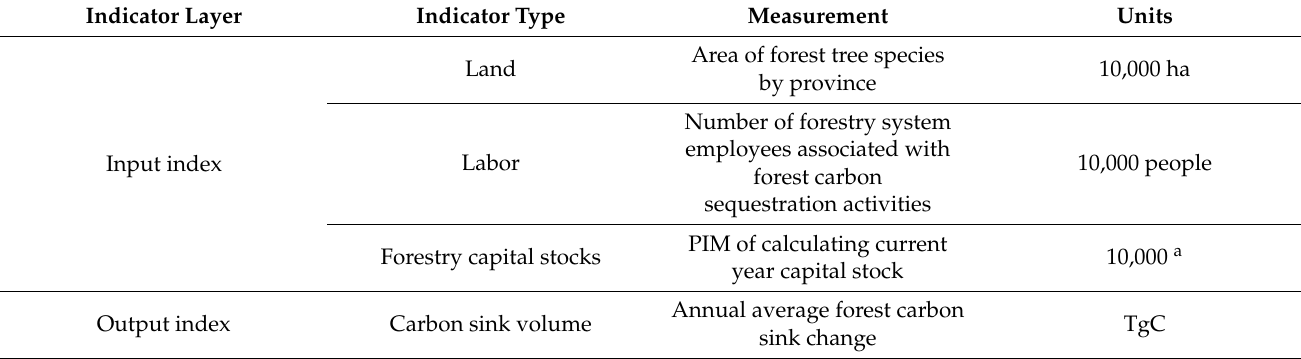
Table 1. Forest carbon sink efficiency input–output